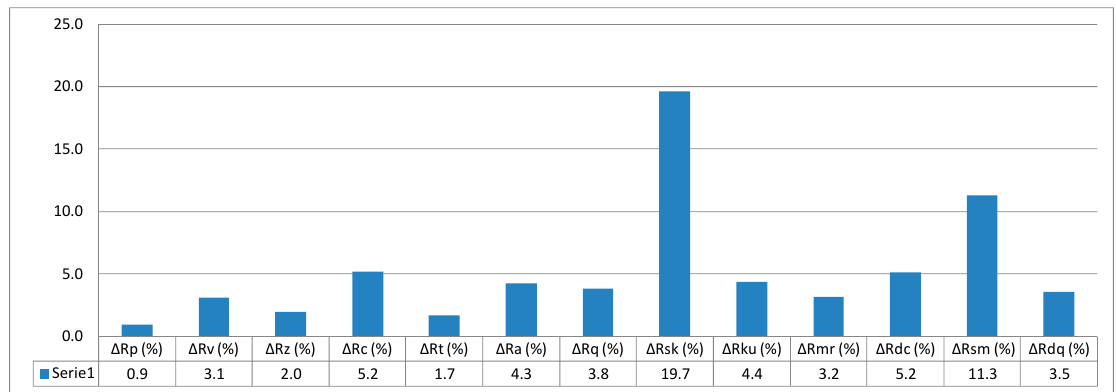
Figure 6. Relative values of surface parameters for printing orientation 45°.